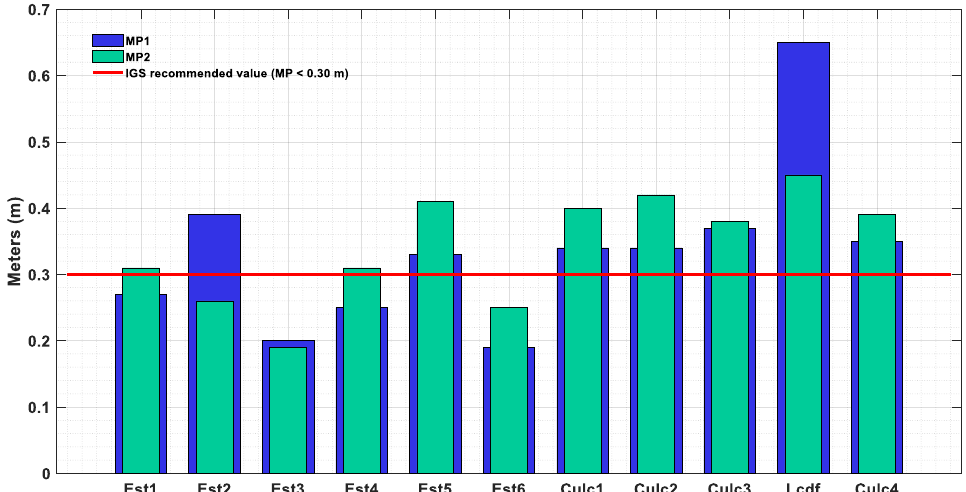
Figure 6. Multipath effect (MP1 and MP2). Red line: maximum value of 0.30 m for the multipath effect [36].